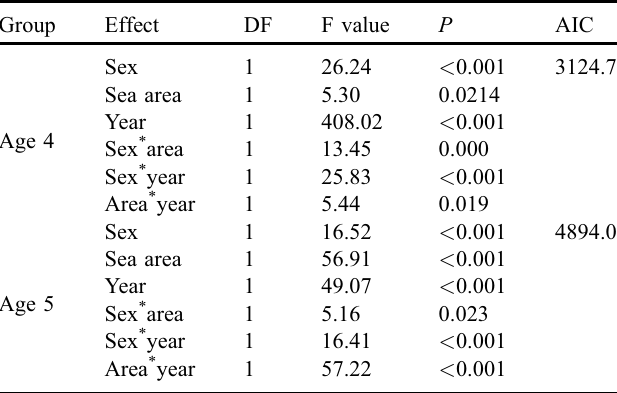
Table A.2. Model for the proportion of mature four- and fi ve-year- old white fi sh in the Gulf of Bothnia during 1998 –